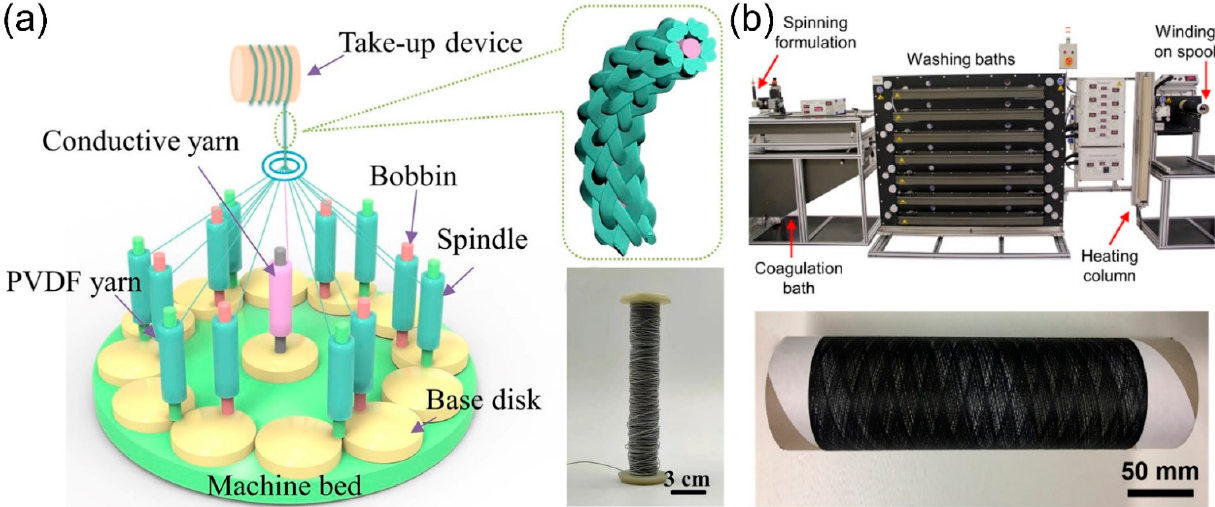
Figure 17. ( a ) Schematic diagram of high-speed rope braiding machine to produce core–shell triboelectric braided fibers on a large scale [138]; and ( b ) digital photographs of the customized wet-spinning set-up and a representative spool containing a few kilometers of the continuous PU/PEDOT:PSS multifilament. Reprinted with permission from Ref. [100]. 2018, Elsevier